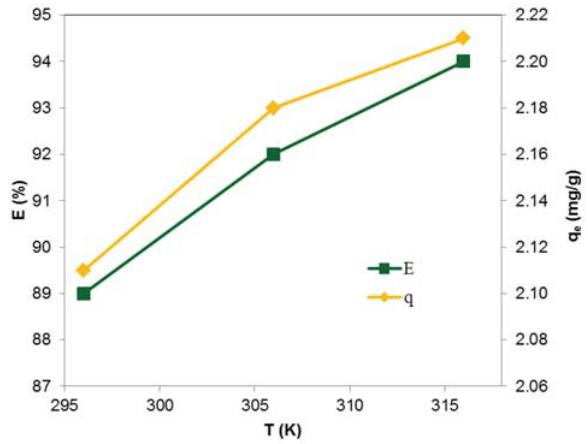
Figure 4. The effect of temperature on MG adsorption onto un- treated WGT; (296 K, 94 mg/L, 100 mL, 4 g, 200–400 μm, 300 rpm, 240 min).